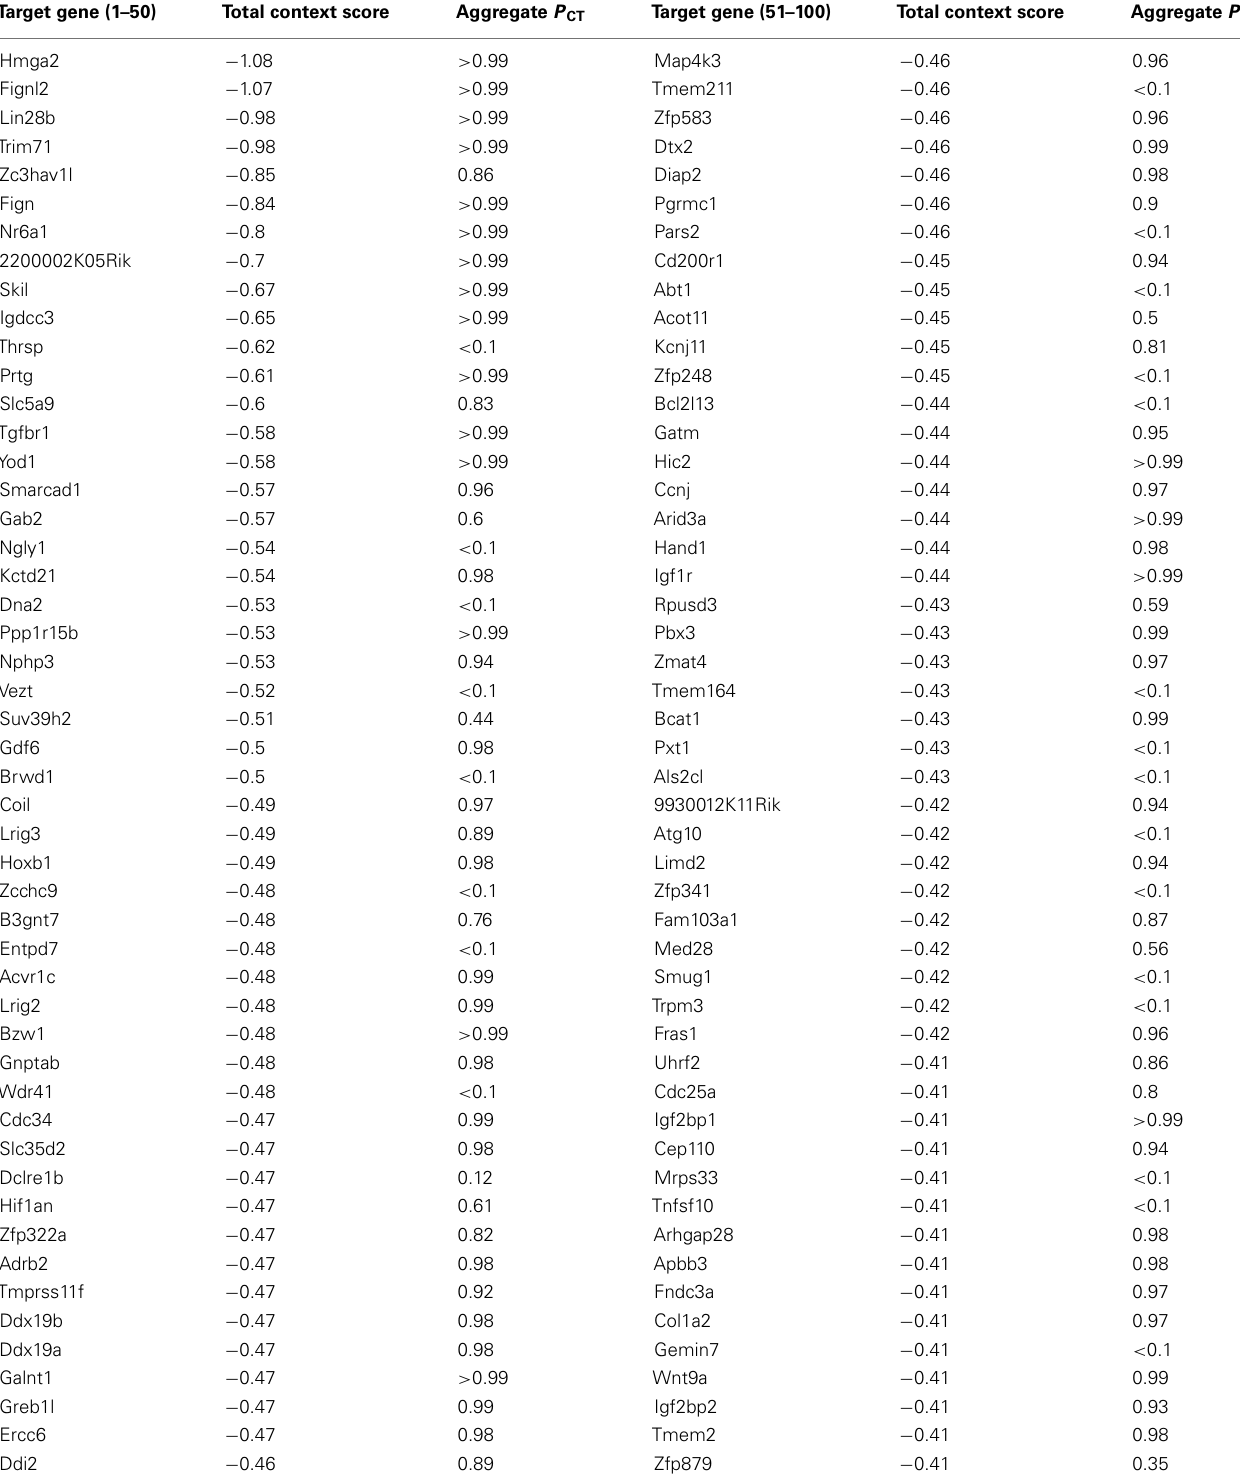
Table 2 |Top 100 predicted targets of let-7 miRNAs ranked by total context score (TargetScan 6.0,